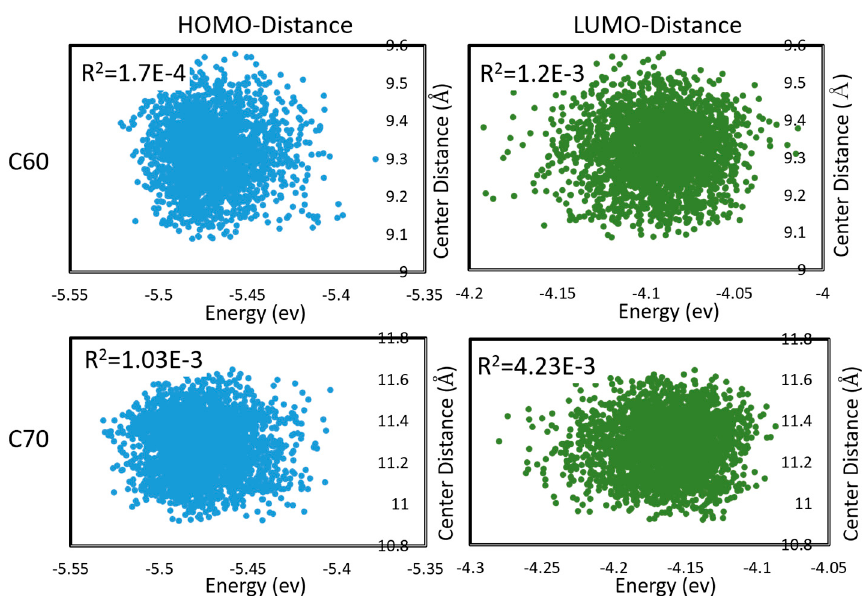
Figure 4. Correlations between HOMO and LUMO energies, and intermolecular distances (between centers of mass) during molecular dynamics in C60 and C70. Pearson R 2 coefficients are also shown. First appeared in [48].